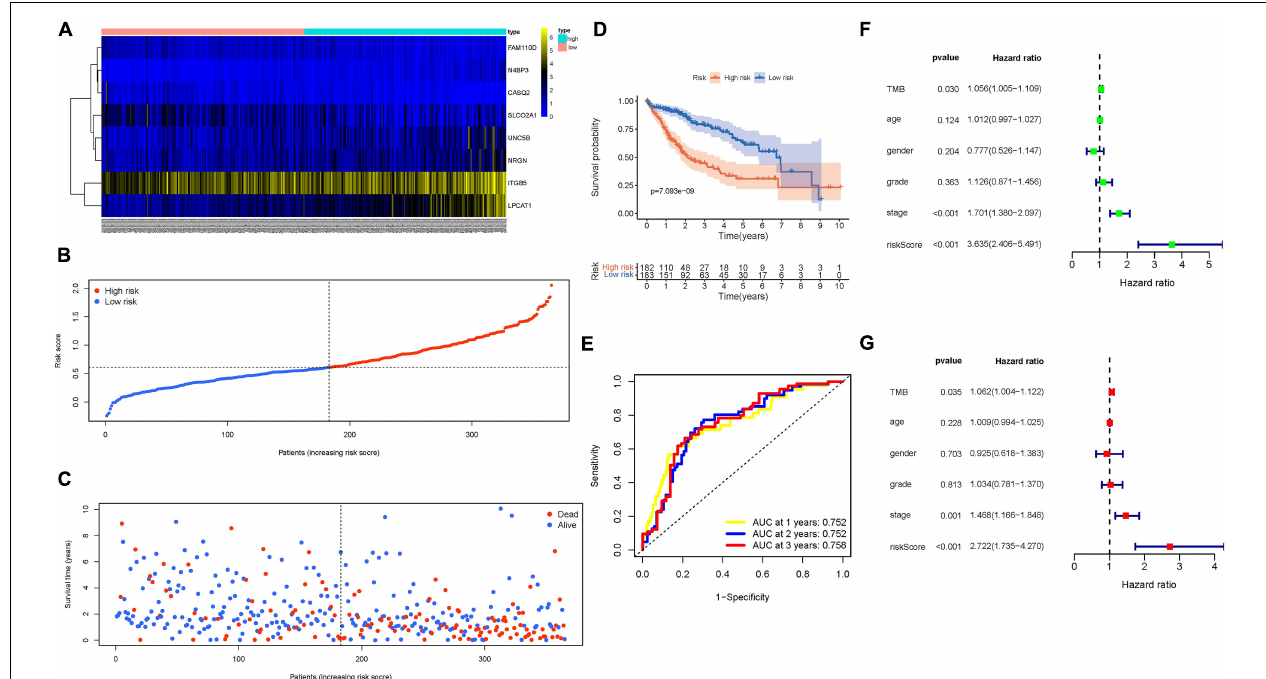
FIGURE 4 | Validation of the prognostic value of risk signature. (A) Heatmap presents the expression pattern of three hub genes in each patient, where the colors of yellow to blue represent alterations from high expression to low expression. (B) Distribution of multi-genes signature risk score. (C) The survival status and interval of HCC patients. (D) Kaplan–Meier curve analysis presenting difference of overall survival between the high-risk and low-risk groups. (E) Areas under curves (AUCs) of the risk scores for predicting 1-, 2-, and 3-year overall survival time. (F) Univariate Cox regression analyses of overall survival. (G) Multivariate Cox regression analyses of overall